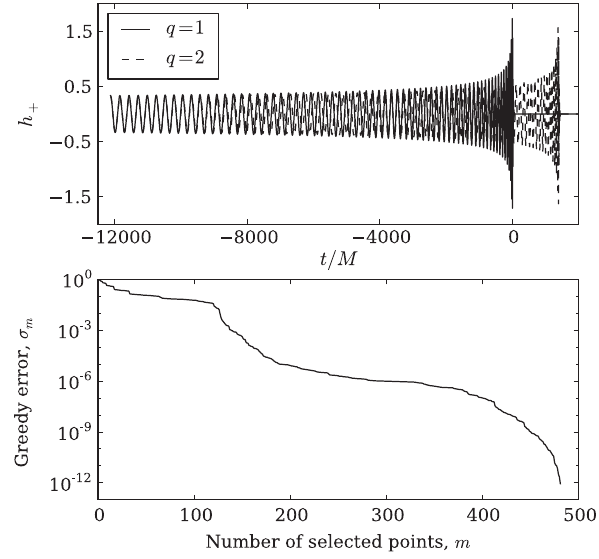
FIG. 14. Top panel: EOB waveforms for q ¼ 1 , 2 starting at the same initial frequency but not aligned at the peak amplitudes. Bottom panel: Not aligning the waveforms results in needing more reduced basis elements to accurately span the space of waveforms. Here, we see that nearly all 501 points in the training space are selected, whereas only 19 points are required if the waveforms are aligned at the peak amplitude (compare with Fig. 3).